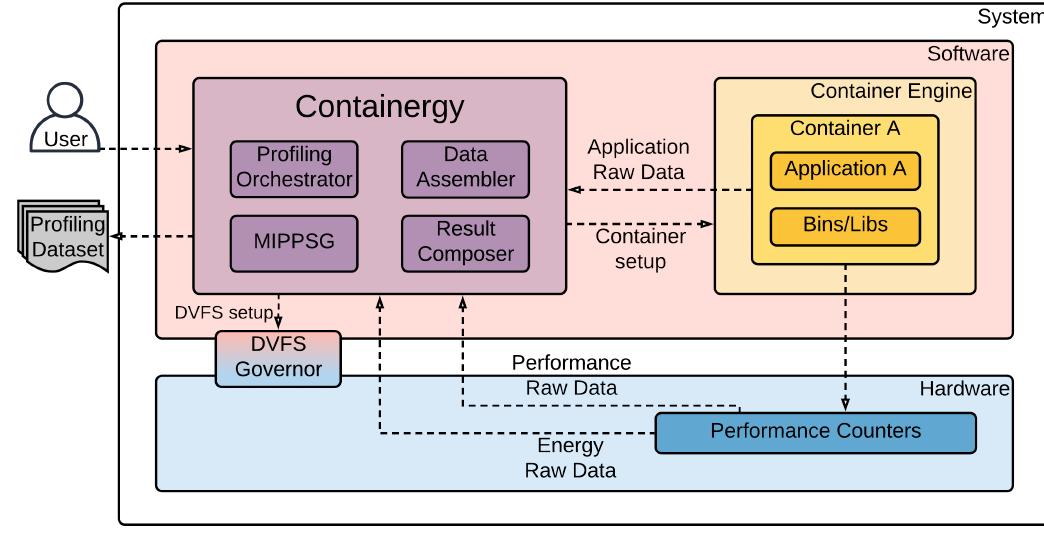
Figure 1. Containergy